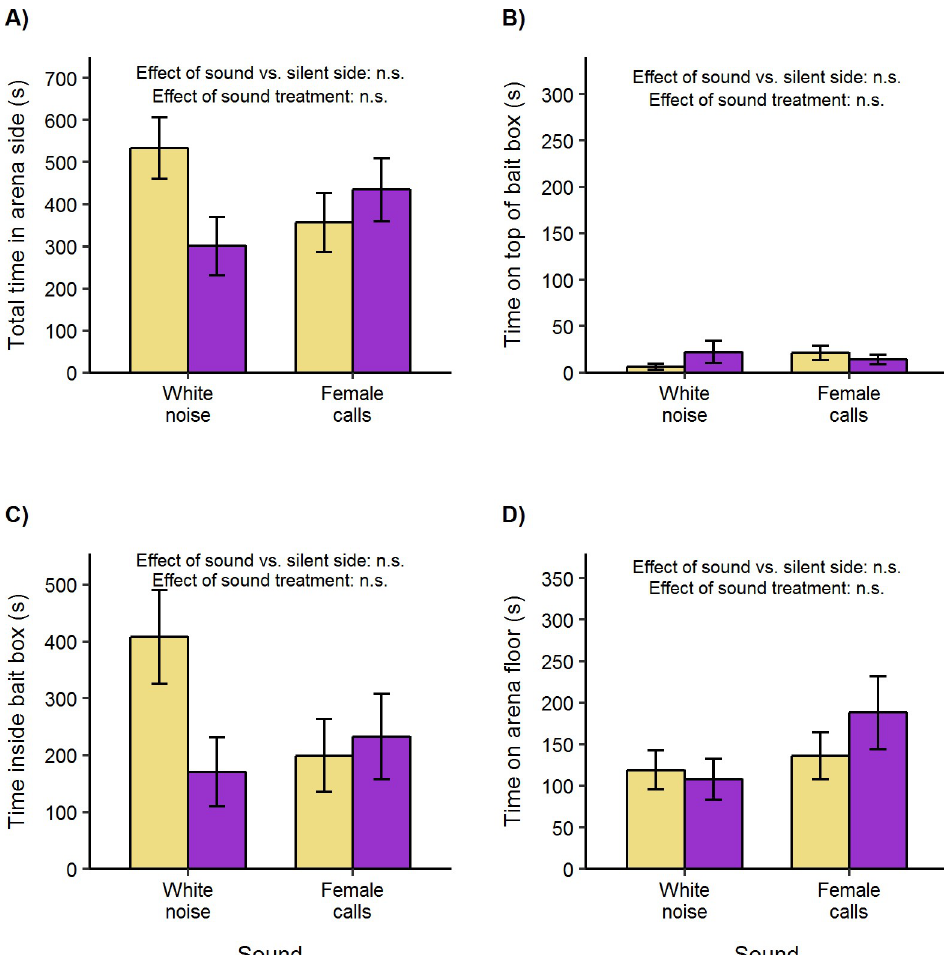
Fig 5. Bank vole response to female rat calls or to white noise playing inside empty bait boxes (mean ± standard error of mean). Adult male and female bank voles were presented with sound playing through a box (purple bars) versus no sound (yellow bars, control) in opposite sides of a test arena. A) Total duration in each side compartment of arena. B) Duration on top of box. C) Duration inside box. D) Duration on arena floor (in arena side but not in or on box). Bias between sides was compared between treatments using repeated measures ANOVA followed by pairwise t- tests (where data approximated normality), or non-parametric two-way ANOVA equivalent followed by Wilcoxon signed-rank tests (where data was not normal). Within each treatment, attraction or avoidance was assessed using one- sample t-tests or Wilcoxon signed-rank tests.